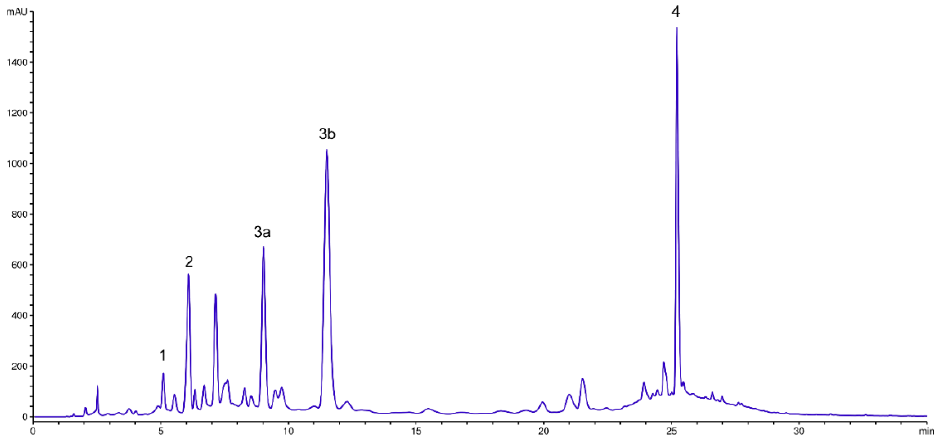
Figure 1. HPLC of PoPEx. 1. Gallic acic; 2. Punicalin; 3a. Punicalagin- α ; 3b. Punicalagin- β ; 4. Ellagic acid.